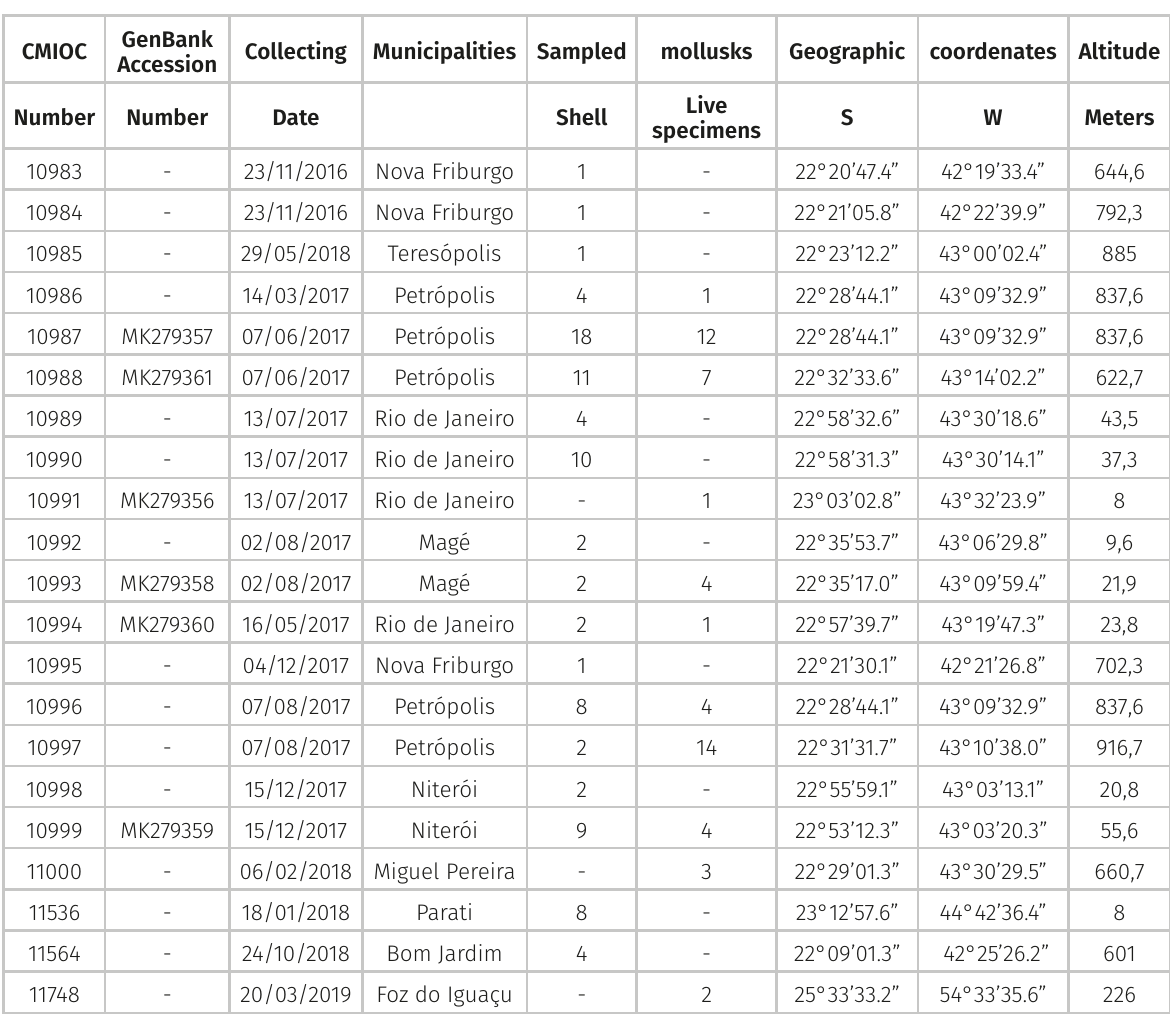
Table I. List of the lots analyzed in the present study and its respective CMIOC Number, GenBank Access Number, collecting date, indication of the kind of sample (live specimen or/and shell), geographic coordinates and altitude of each site. Sequenced specimen was individualized in its respective CMIOC